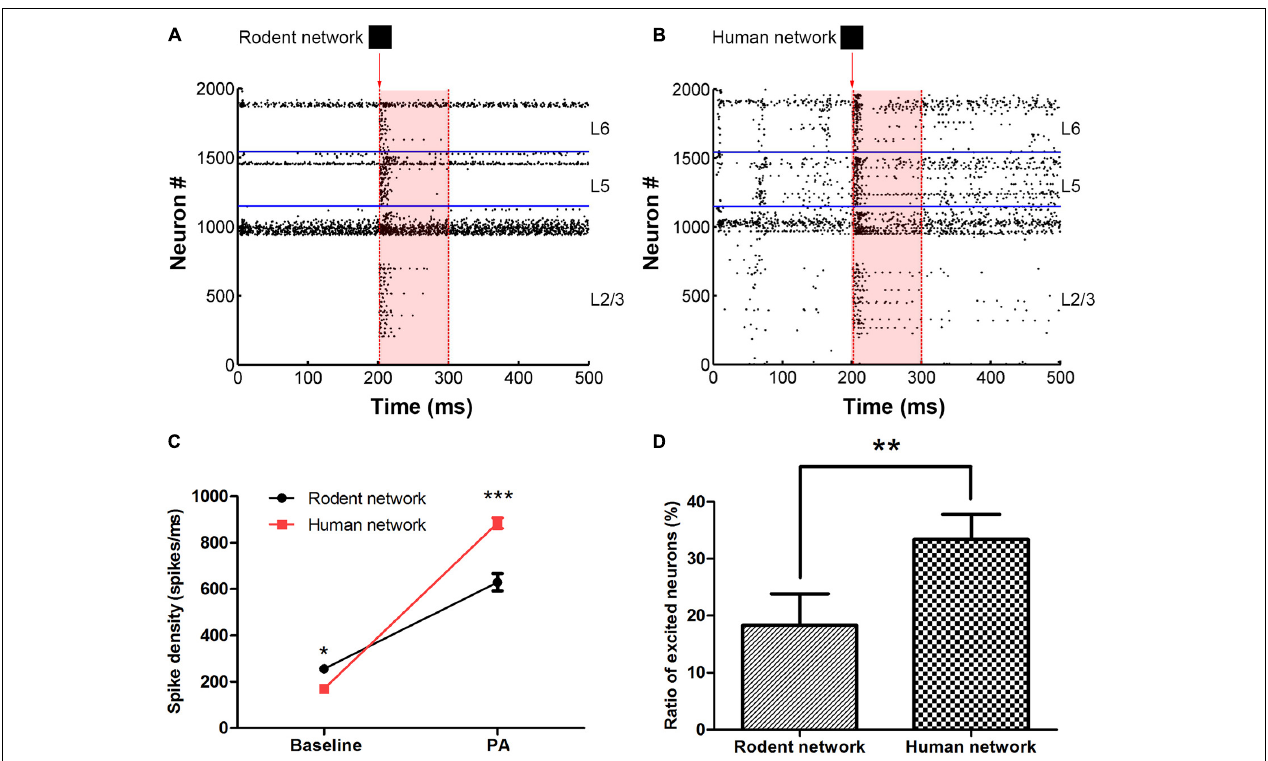
FIGURE 2 | The comparison between rodent (A) and human neural network (B) under the same image input. The red arrow indicates that in 201 ms, input pattern stimulates the layer 2/3 pyramidal cell. The shades of light red indicate the persistent activity. The horizontal blue line is the dividing line between the layers. (C) Statistics representing the network spikes density in the two stages, at baseline and persistent activity (PA). (D) The ratio of excited neurons between rodent and human neural network. The error bars represent the standard error of the mean of nine independent experiments, * P < 0.05, ** P < 0.01, *** P <